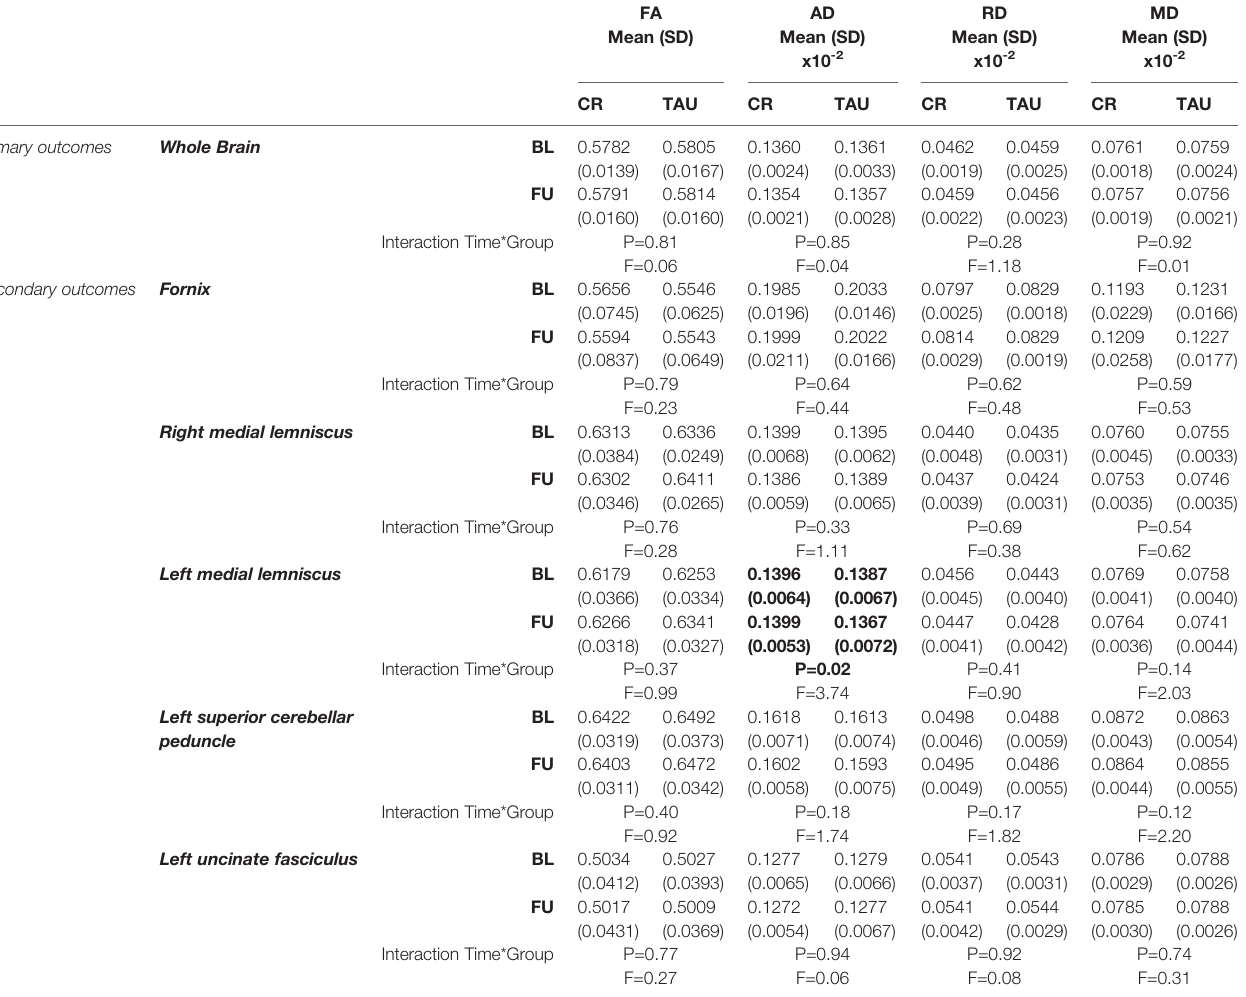
TABLE 3 | White matter characteristics at baseline and follow-up in individuals at ultra-high risk for